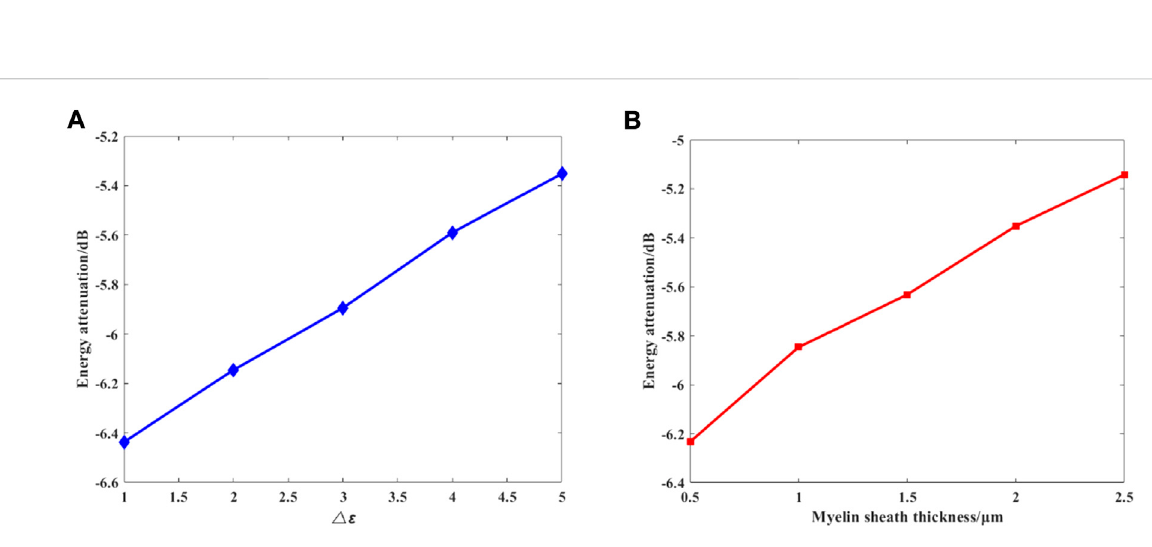
results of the CST simulation software. The results are shown in Figure 9. Compared with the result calculated by CST software, the results of the theoretical calculation are consistent with those from CST simulation software, which veri fi es the accuracy of our